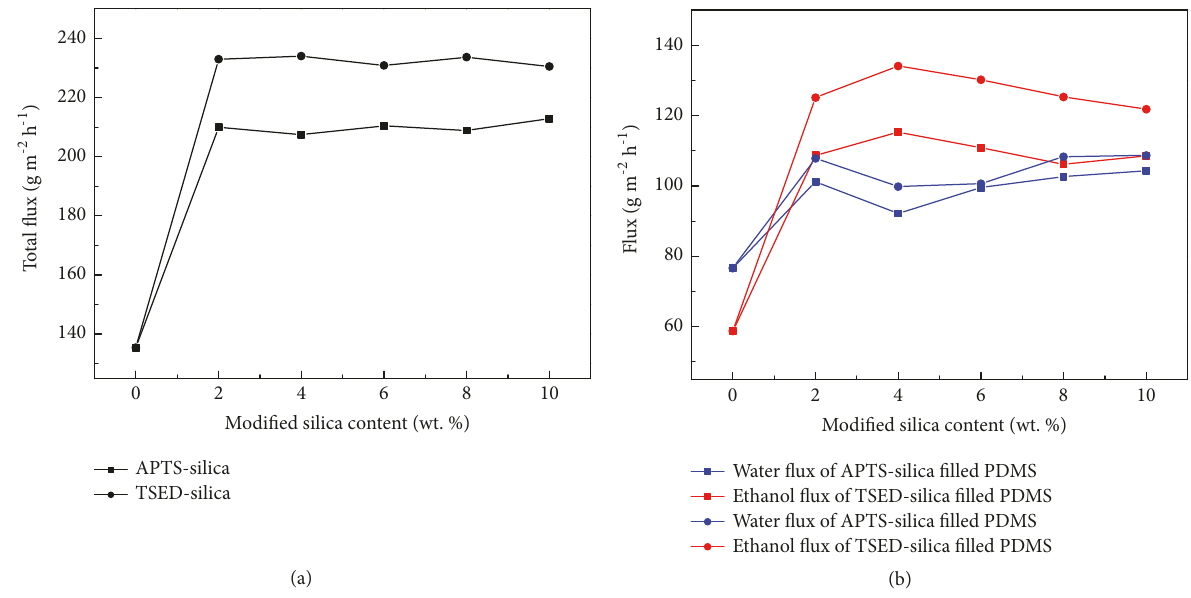
Figure 7: Effect of modified fumed silica content on permeation flux: (a) total flux, (b) ethanol and water fluxes.